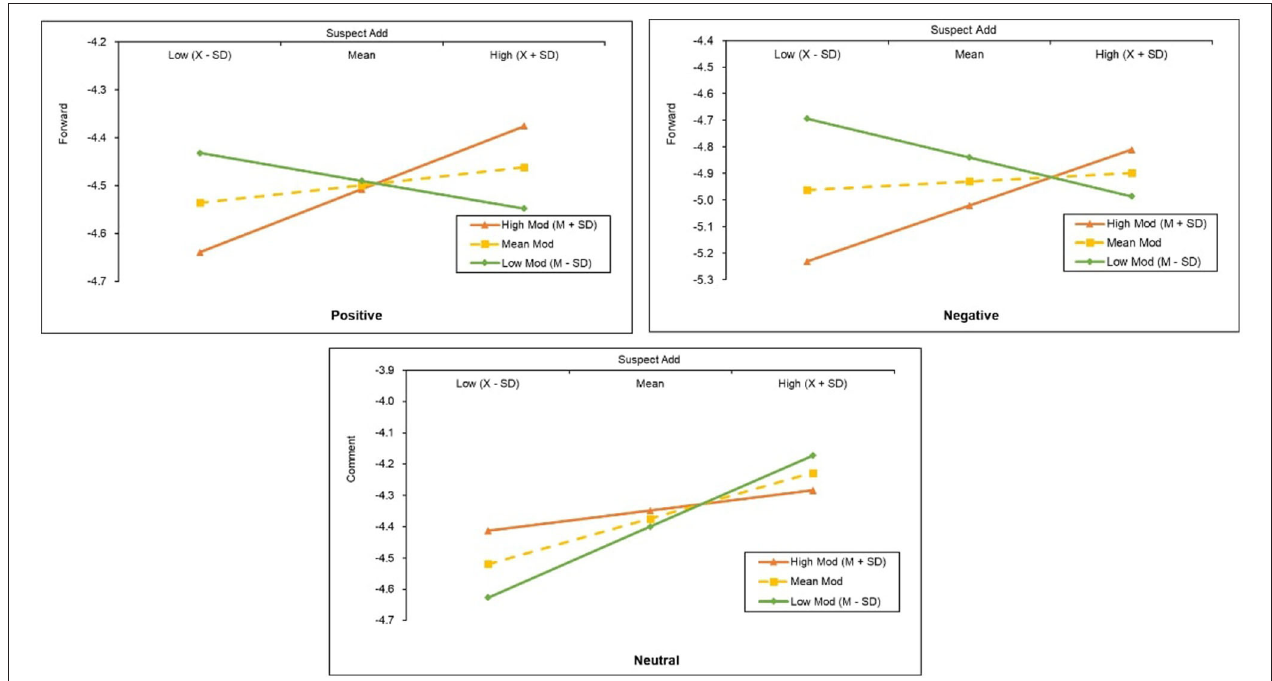
FIGURE 2 | Simple slope test graphs. A simple slope plot represents the direction and strength of the moderating